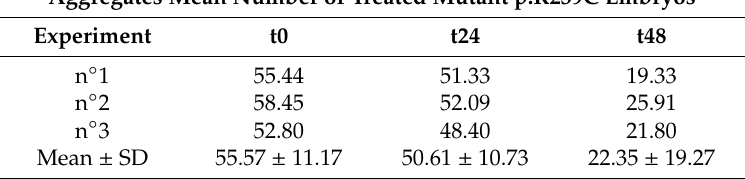
Table 2. Details of the aggregates number count are reported for untreated mutant p.R239C embryos.. Means and standard deviations are described at the bottom the table.